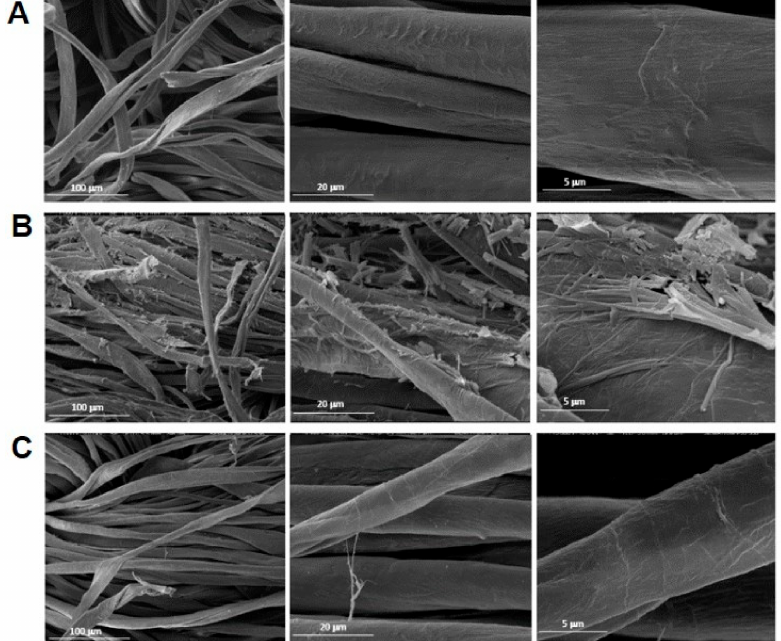
Figure 8. STEM images of a hydrogel formed within cotton gauze wound dressing. ( A ): Control, cotton dressing submerged in NaOH/GdL solution (without hydrogelator 2, without UV exposure). ( B ): Hydrogel formed within the cotton dressing, by submerging in hydrogelator 2/NaOH/GdL solution (without UV exposure). ( C ): Cotton dressing submerged in hydrogelator 2/NaOH/GdL solution, and then exposed to UV light (360 nm, 1